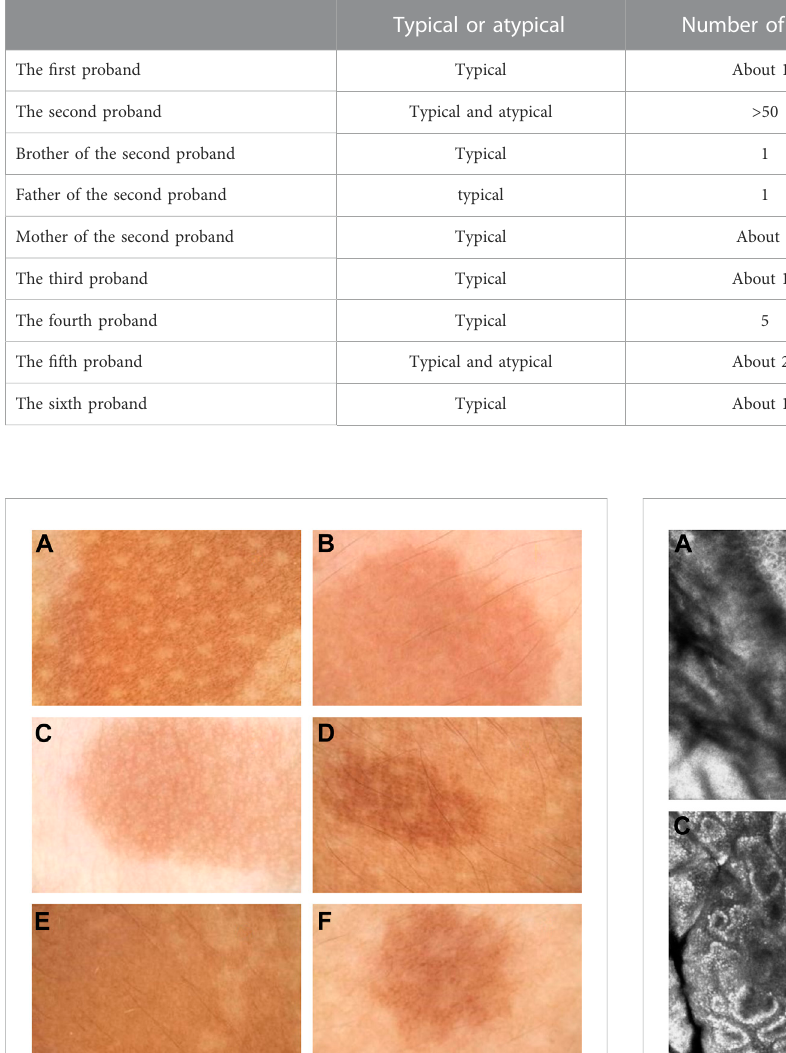
TABLE 2 The characteristics of CALMs in all affected individuals.